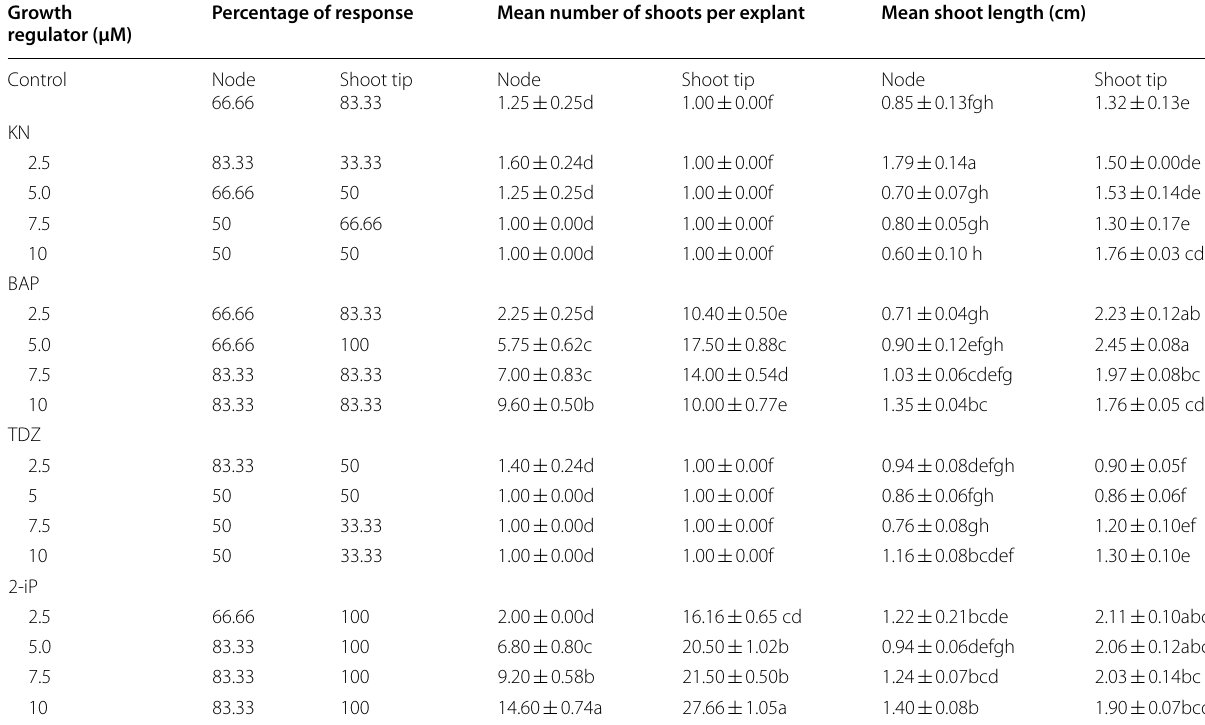
Table 1 Influence of cytokinins supplemented to Murashige and Skoog medium on In vitro regeneration of shoots from Andrographis producta using nodal and shoot tip